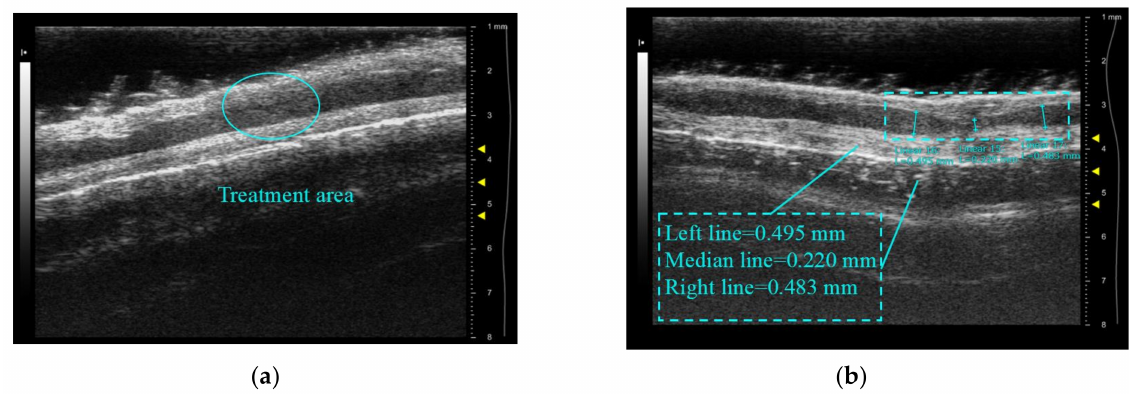
Figure 12. Comparison of rabbit marginal ear vein: ( a ) before treatment; ( b ) after treatment.